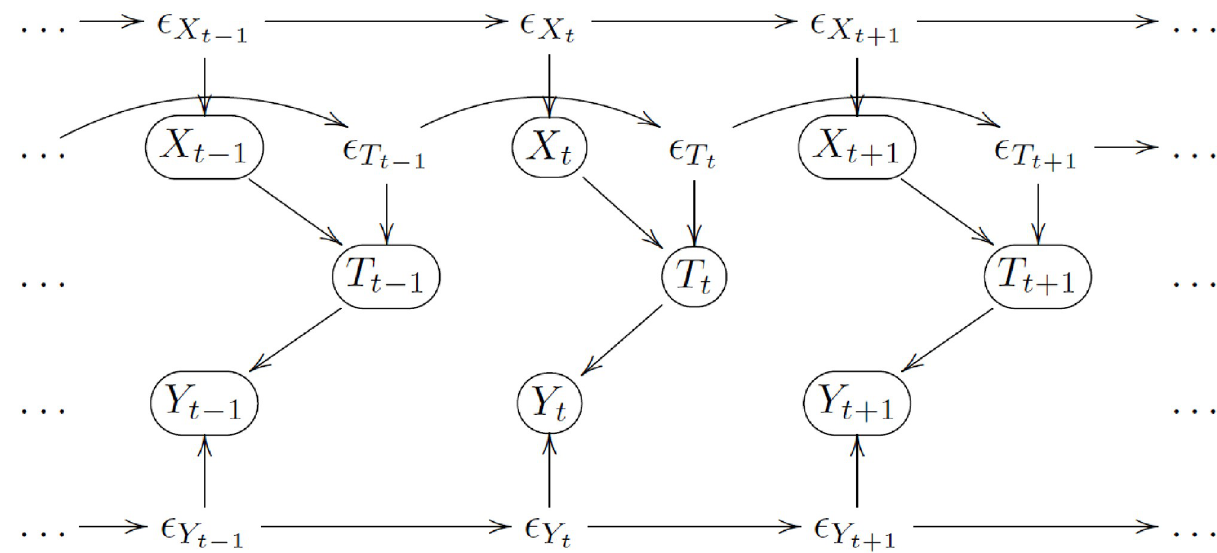
Fig 4. Dynamic version of model M 2 in Fig